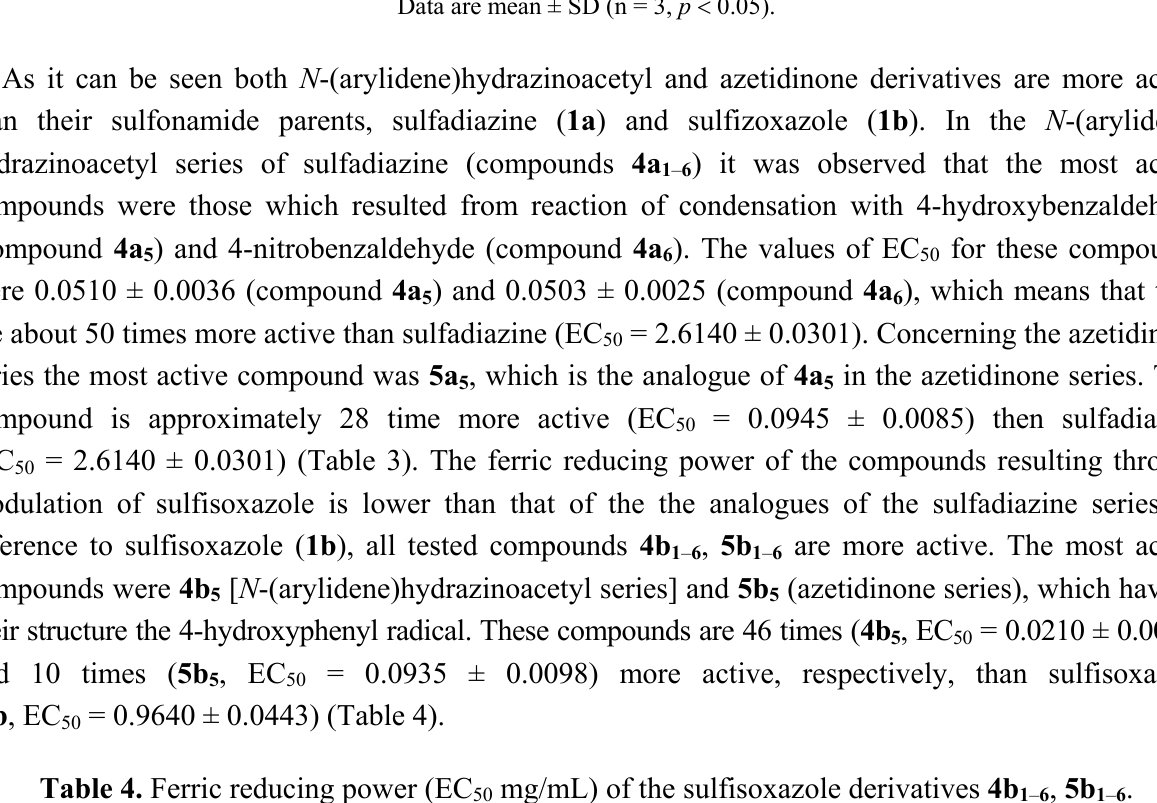
Table 4. Ferric reducing power (EC